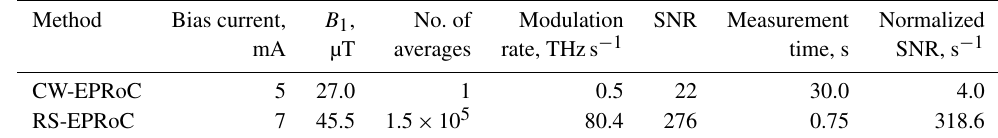
Table 1. SNR for the CW-EPRoC and RS-EPRoC methods.